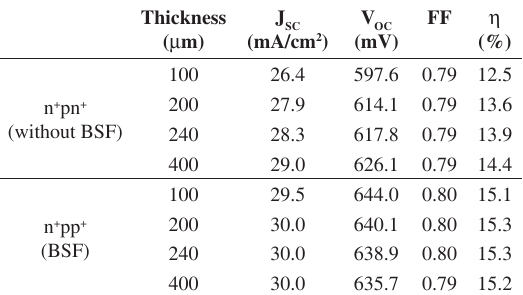
Table 2. Electrical parameters of the solar cells simulated as a function of thickness of the silicon multicrystalline wafer. Thickness ( µ